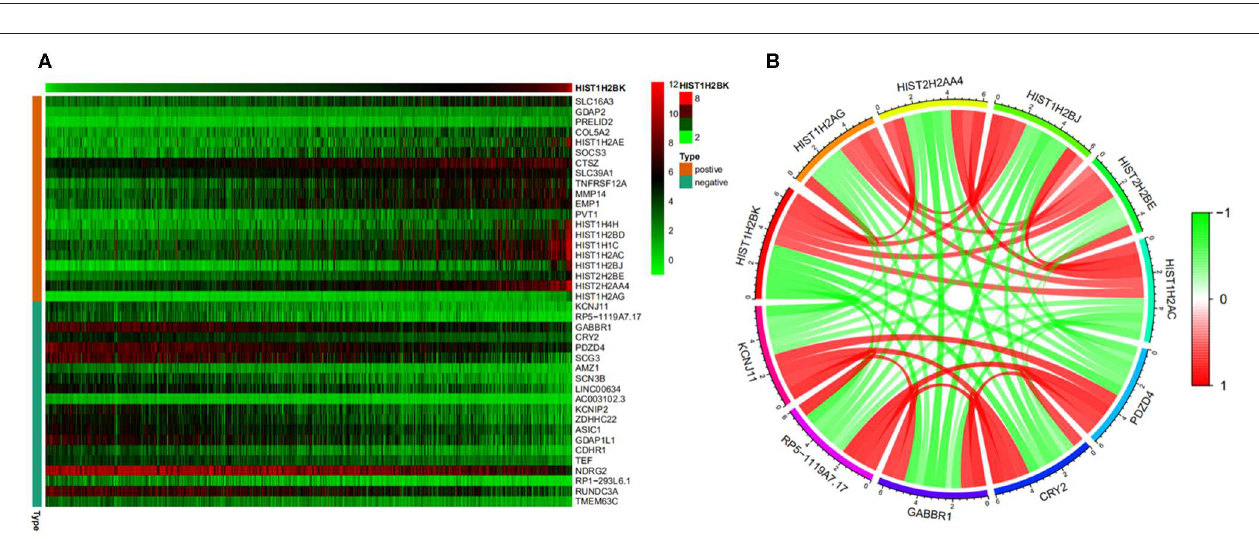
FIGURE 7 | Relationship between copy number variation of HIST1H2BK and immune infiltration level in glioma. * P < 0.05; *** P < 0.001. GBM, glioblastoma; LGG, low grade glioma.